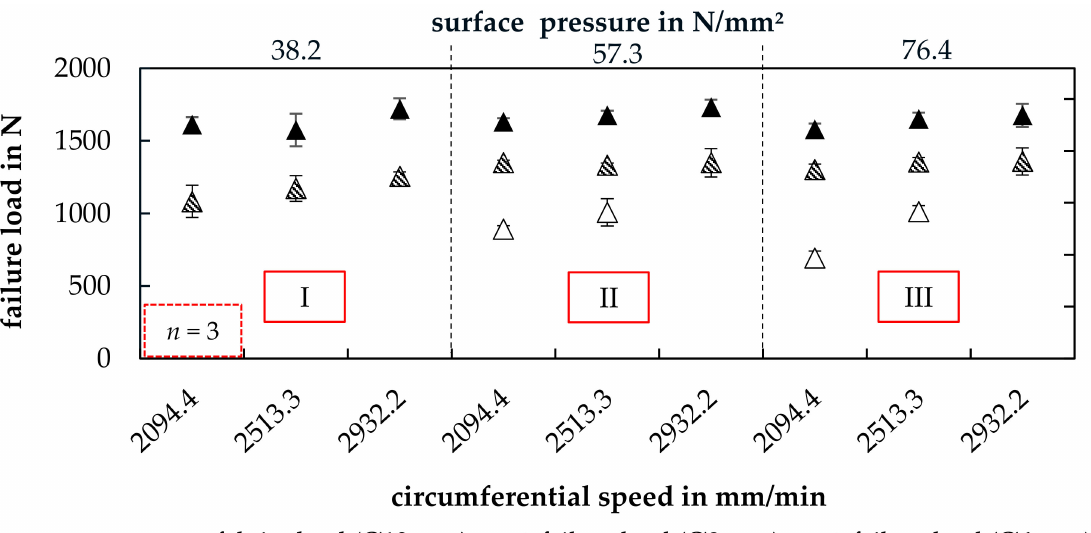
Figure 17. Effects of tool downscaling on the failure